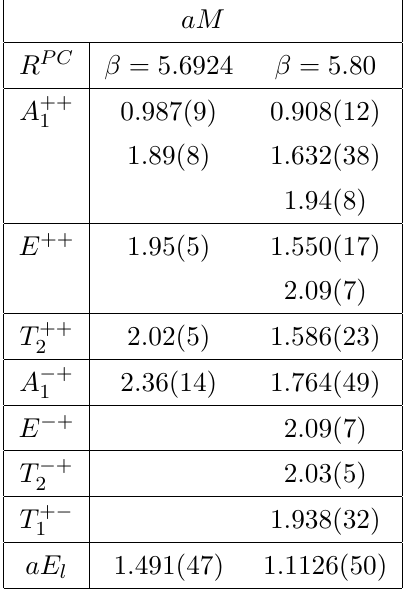
Table 7 . Glueball masses at β = 5 . 6924 and β = 5 . 80 on a 10 3 16 and 12 3 16 lattices respectively, for all octahedral representations R , and for both values of parity, P , and charge conjugation, C . Also the energy E l of a winding flux